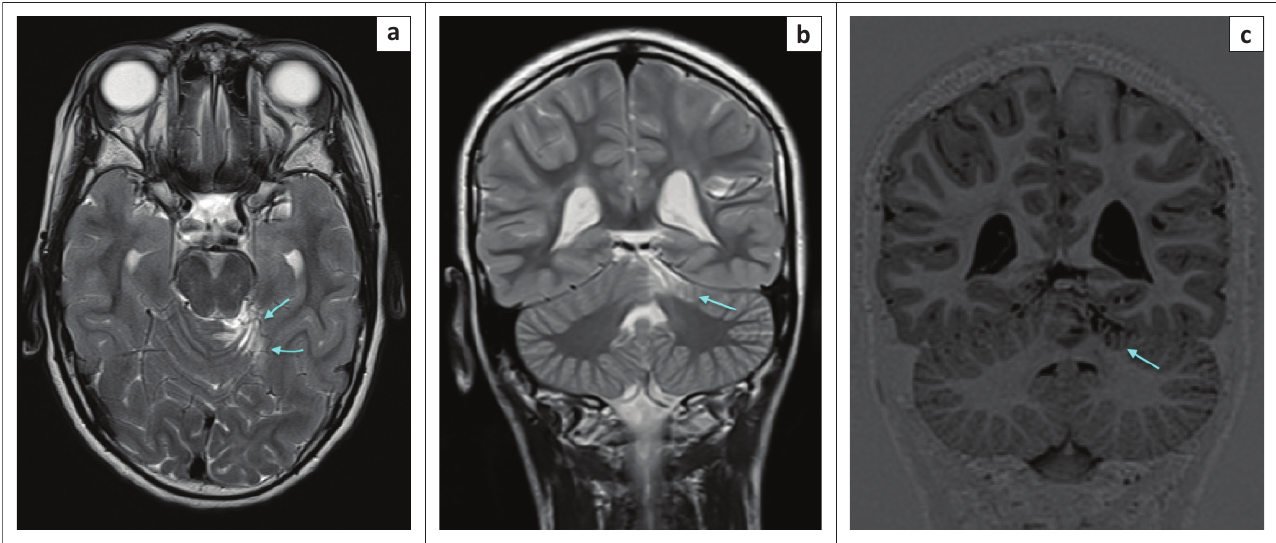
FIGURE 11: A 9-year-old male child who suffered grade 3 hypoxic ischemic brain injury with Apgar scores of zero at 1 min and 7 at 5 min. (a) An axial T2-weighted, (b) a coronal T2-weighted and (c) a coronal inversion recovery (IR) sequence image demonstrating the left superior cerebellar cortex injury (cyan blue arrows) with localised atrophy involving the left half of the quadrangular lobule. This is an important review area, as in this case, the injury was omitted by the first reporter.